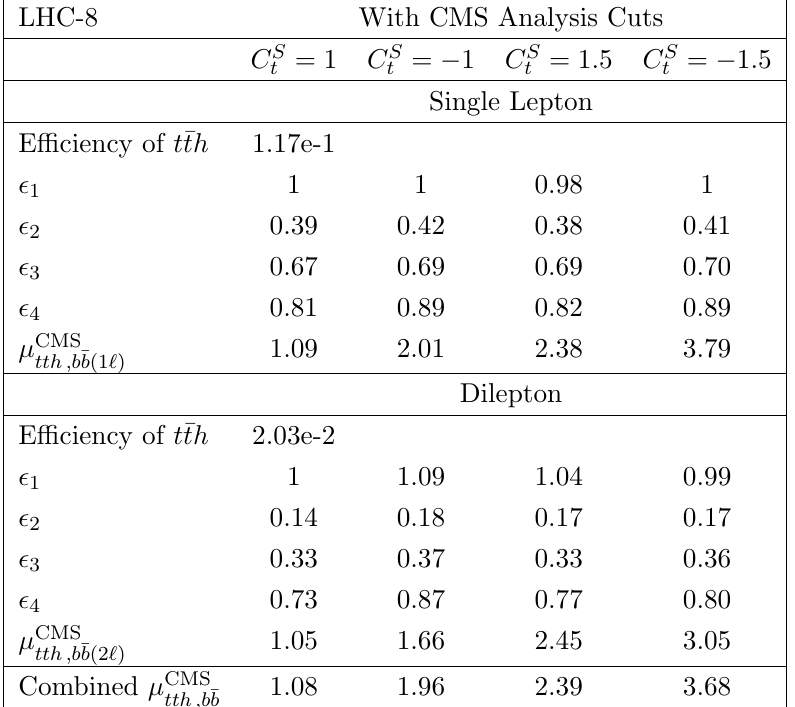
(left) and (cid:22) CMS (lower right) tth;b (cid:22) b tth;b (cid:22) b = t